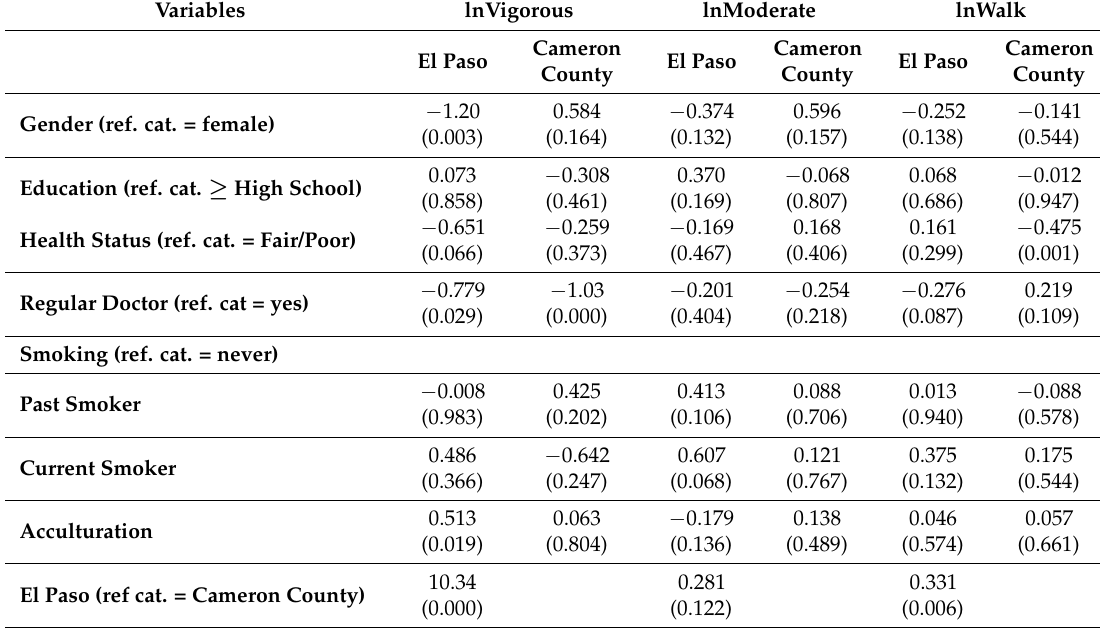
Table 3. Adjusted regression results for natural log IPAQ outcomes El Paso vs. Cameron